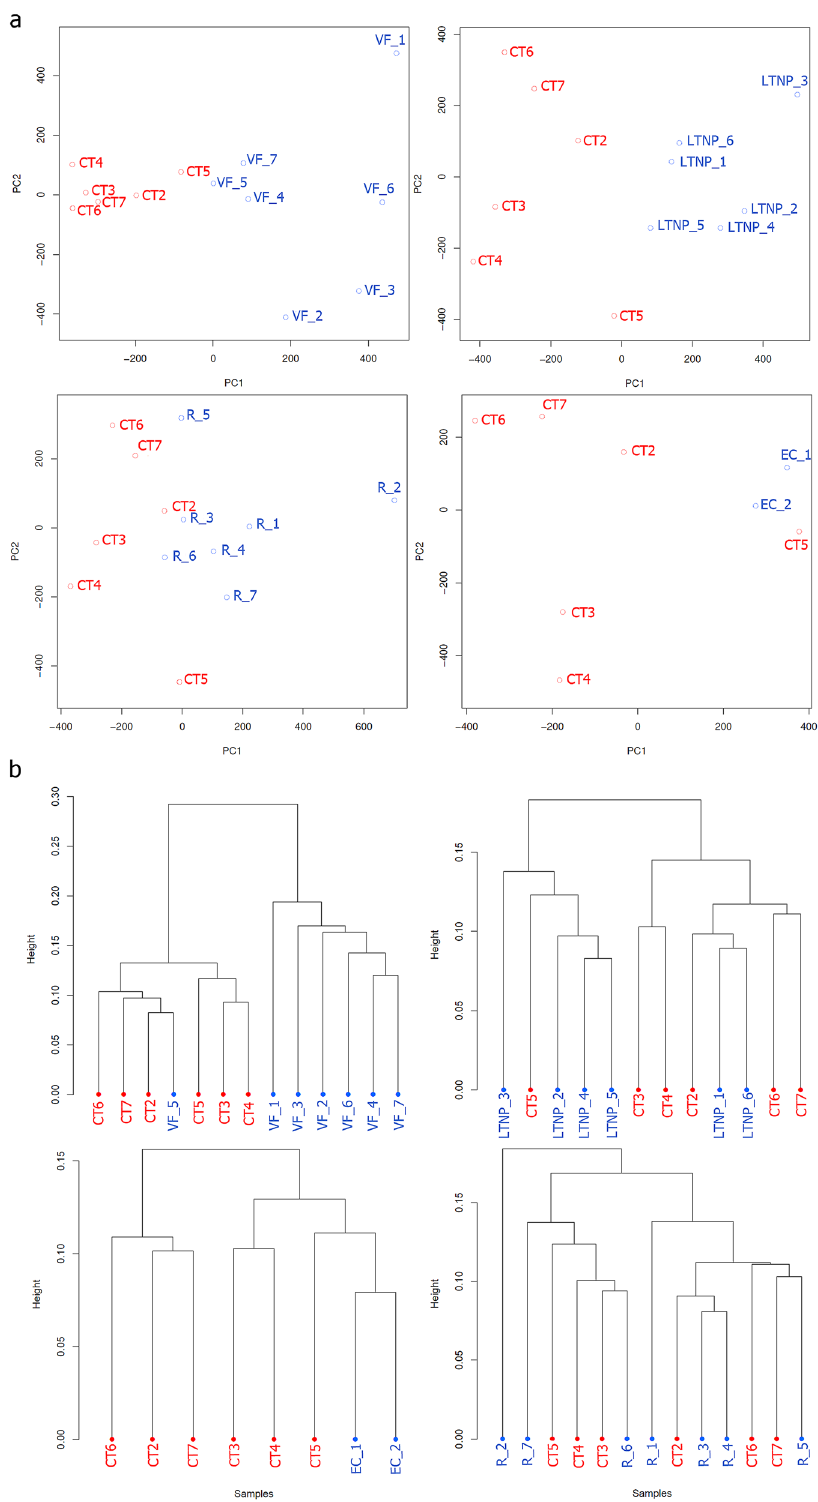
Figure 1. Clustering analysis of CpG methylation profiles. ( a ) Principal Component Analysis (PCA) of four methylation profiles comparisons between HIV groups and controls. ( b ) Hierarchical clustering of four methylation profiles comparisons based on 1-Pearson’s correlation distance. Red denotes healthy controls and blue denotes HIV samples. CT Control group, EC Elite controller, LTNP Long-term nonprogressor, R virologic responder, VF virologic